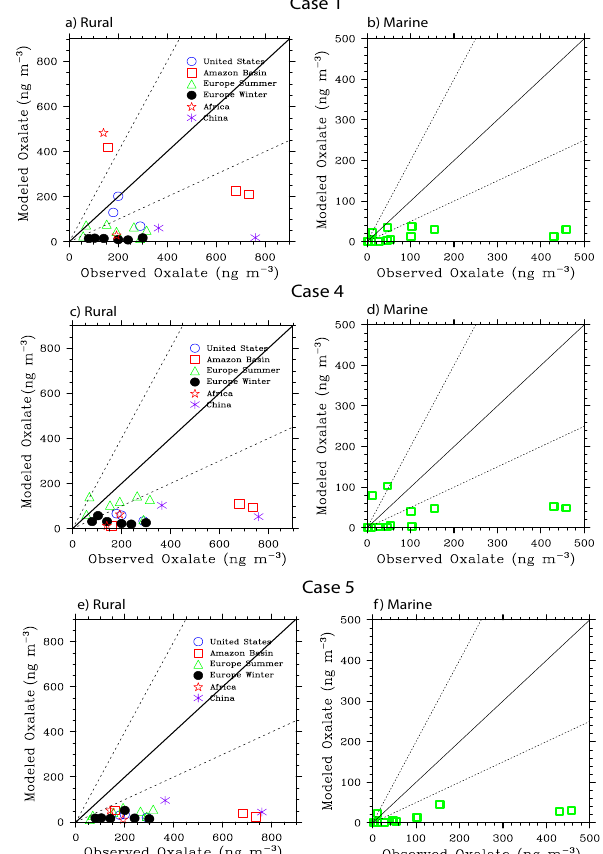
Figure 6. Comparison of the oxalate mass concentrations observed at rural and marine sites adopted from Table S3 of Myriokefalitakis et al. (2011) with the oxalic acid concentrations simulated in Case 1, Case 4 and Case 5. Solid lines show the 1:1 ratio, and dashed lines show the 1:2 and 2:1 ratios. The measurements at the various sites were made in different seasons and different years between 1980 and 2007 and most of them were reported with several days of sampling duration. The model results are the average values over the same months as the observations.